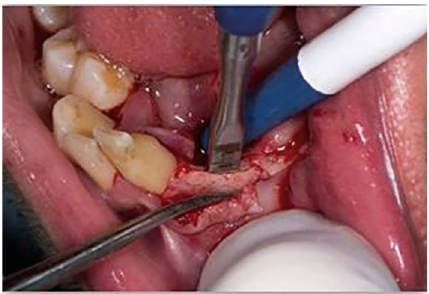
Figure 2: Representative photomicrograph of odontogenic myxoma (hematoxylin and eosin, original magni fi cation 100x).